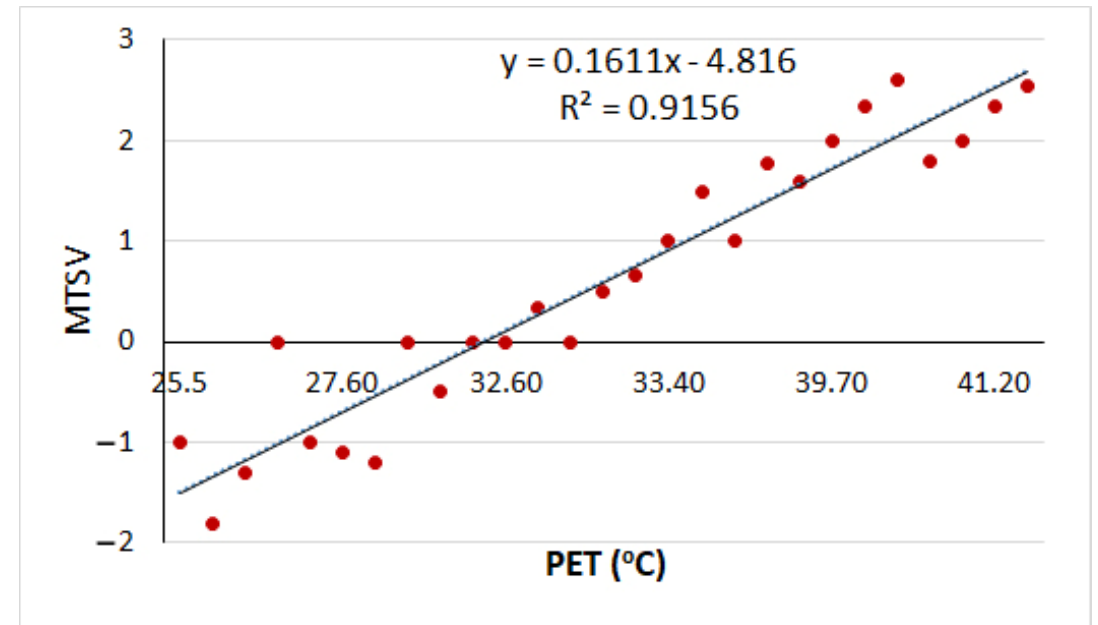
Figure 7. Correlation between actual physiological equivalent temperature (PET) and thermal sensation votes in Al Khayamiya